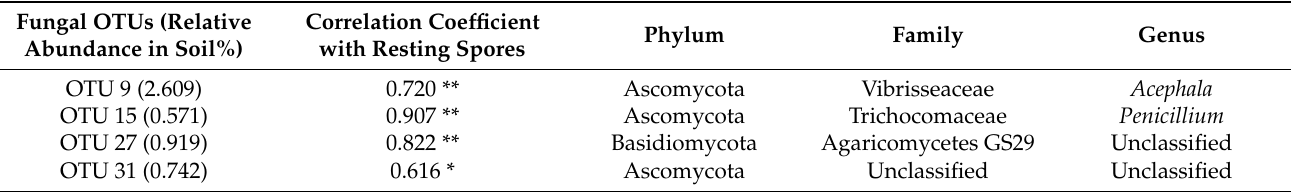
Table 5. Correlation analysis between resting spores and soil fungal